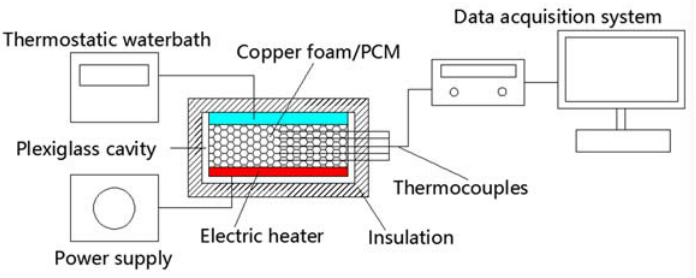
Figure 3. Experimental apparatus for effective thermal conductivity measurement.